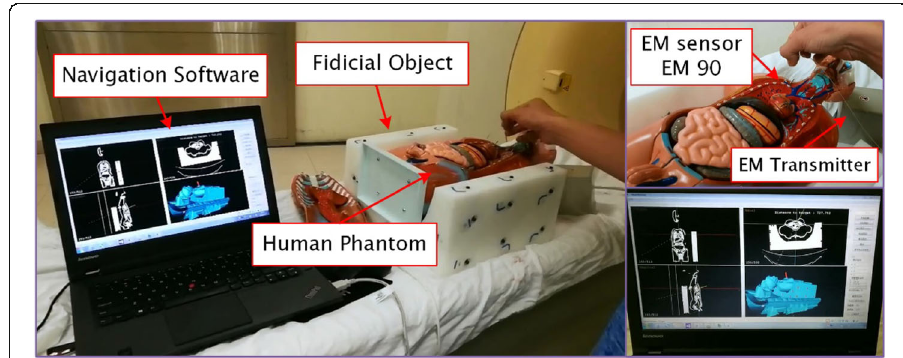
Fig. 11 Platform of electromagnetic navigation